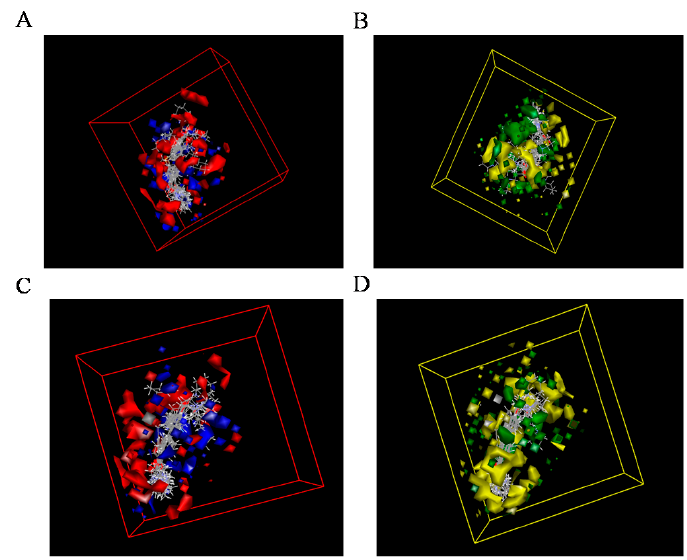
Figure 2. Plot of the experimental versus predicted AChE and BuChE inhibitory activities of the training set and test set. The correlation coefficient R 2 of AChE and BuChE 3D-QSAR models between determined and predicted activities of training set were 0.925 and 0.883 ( A , C ). The R 2 of AChE and BuChE test set were found to be 0.850 and 0.881( B , D ), respectively.